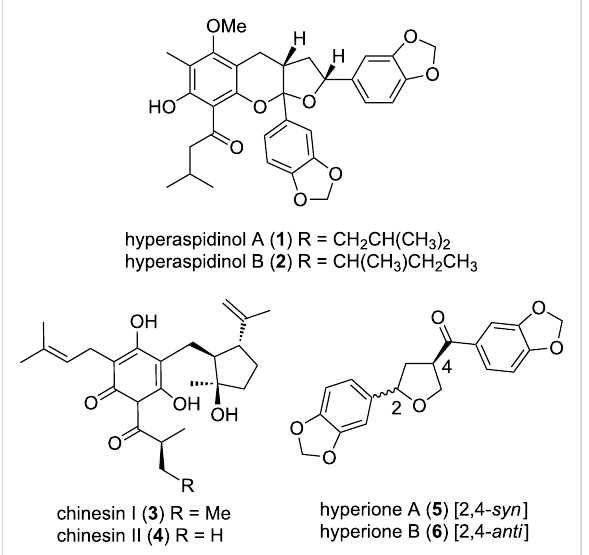
Figure 1: Hyperaspidinols A ( 1 ) and B ( 2 ) and other compounds 3-6 from Hypericum chinense .